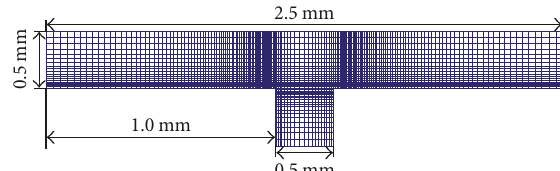
Figure 1: The dead-end model cells.